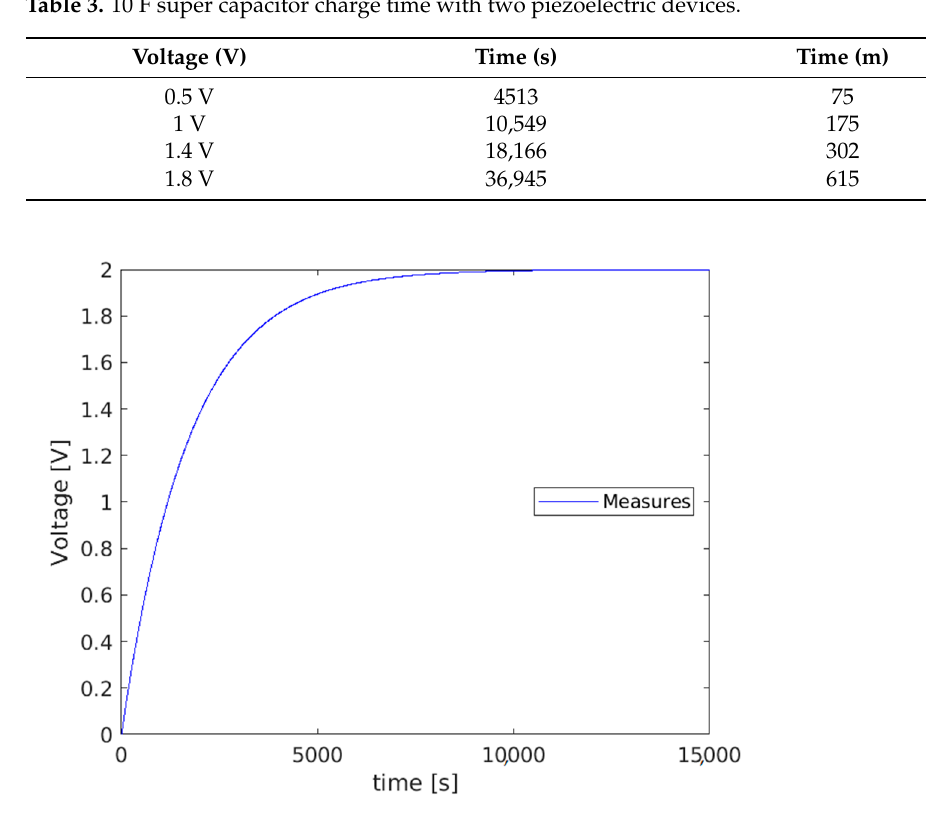
Figure 17. Emulation of the capacitors’ charge with a current-limited voltage source.